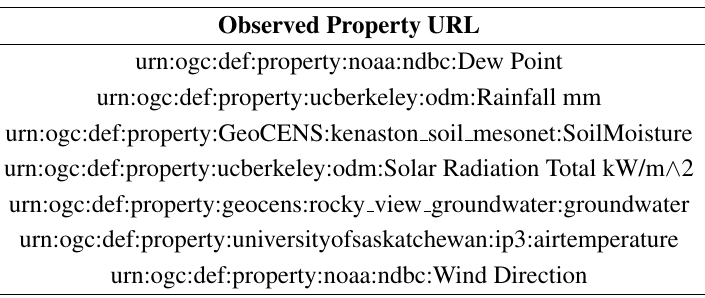
Table 8. Ground truth property layers for testing. Observed Property